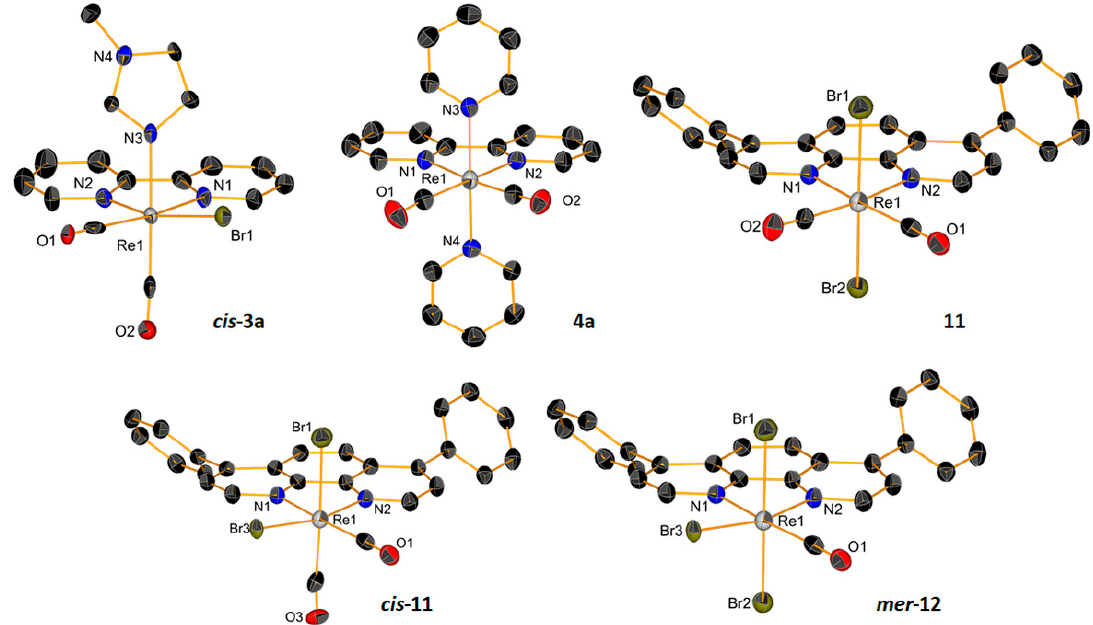
Figure 2. ORTEP representations of the crystal structures of Re dicarbonyl complexes. Thermal ellipsoids are at 30% probability. Hydrogen atoms are omitted for clarity. Note : the compounds cis - 11 and mer - 12 co-crystallize in a mixture, where 10 and 11 are also present.